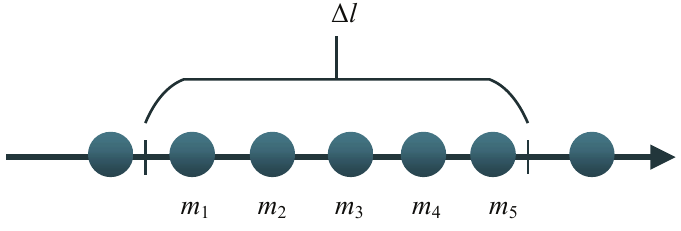
Figure 7. A large ∆ l introducing redundant